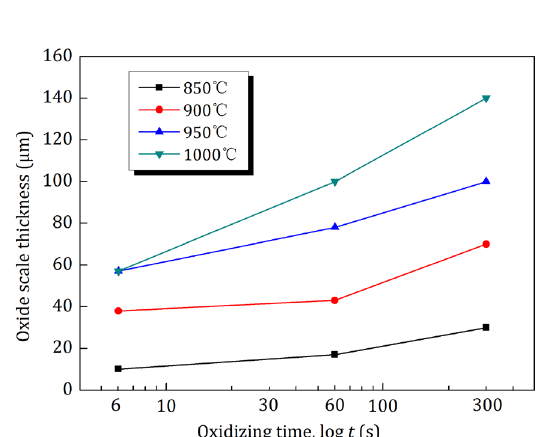
Figure 2. Thickness of oxide scales of steel strip in different heat processes.